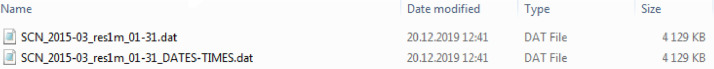
Organization of the processed data files: 1-min data for averages over all visible satellites.